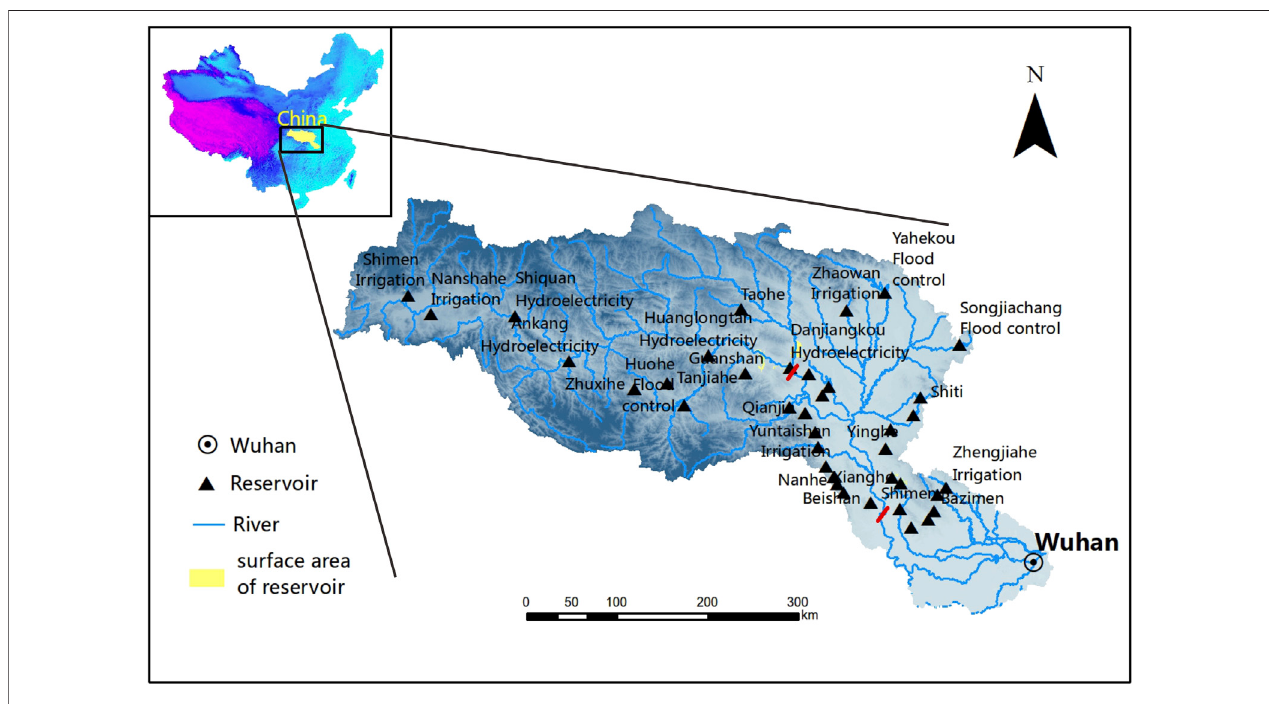
FIGURE 1 | Maps of the Han River basin.